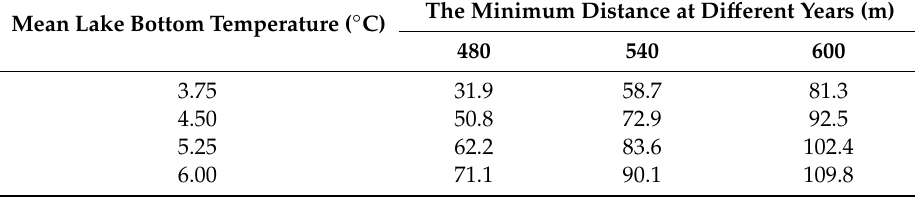
Figure 5. The vertical profiles of the open talik below the thermokarst lakes with di ff erent mean annual lake bottom temperatures on the last day of year 540 after the thermokarst lakes’ formation. Table 3. The minimum distances from open talik profiles to lake centerlines below the lakes with di ff erent mean annual lake bottom temperatures at di ff erent